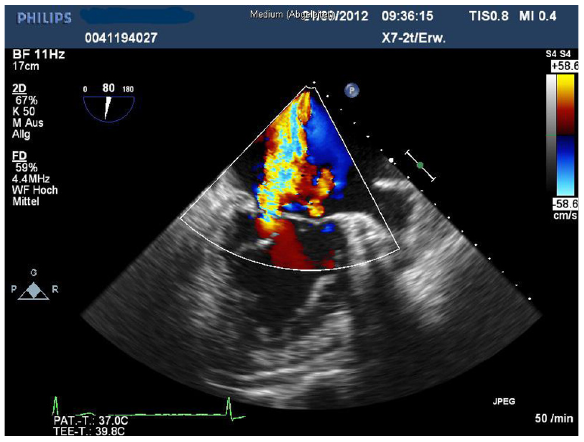
Figure 3 . Intraprocedural transesophageal echocardiogram with pull out of the anterior lea fl et.